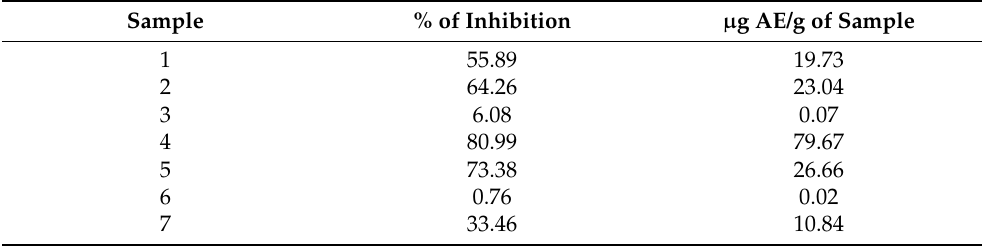
Table 16. Results expressed as percentage of inhibition and in µ g AE/g of sample (ABTS